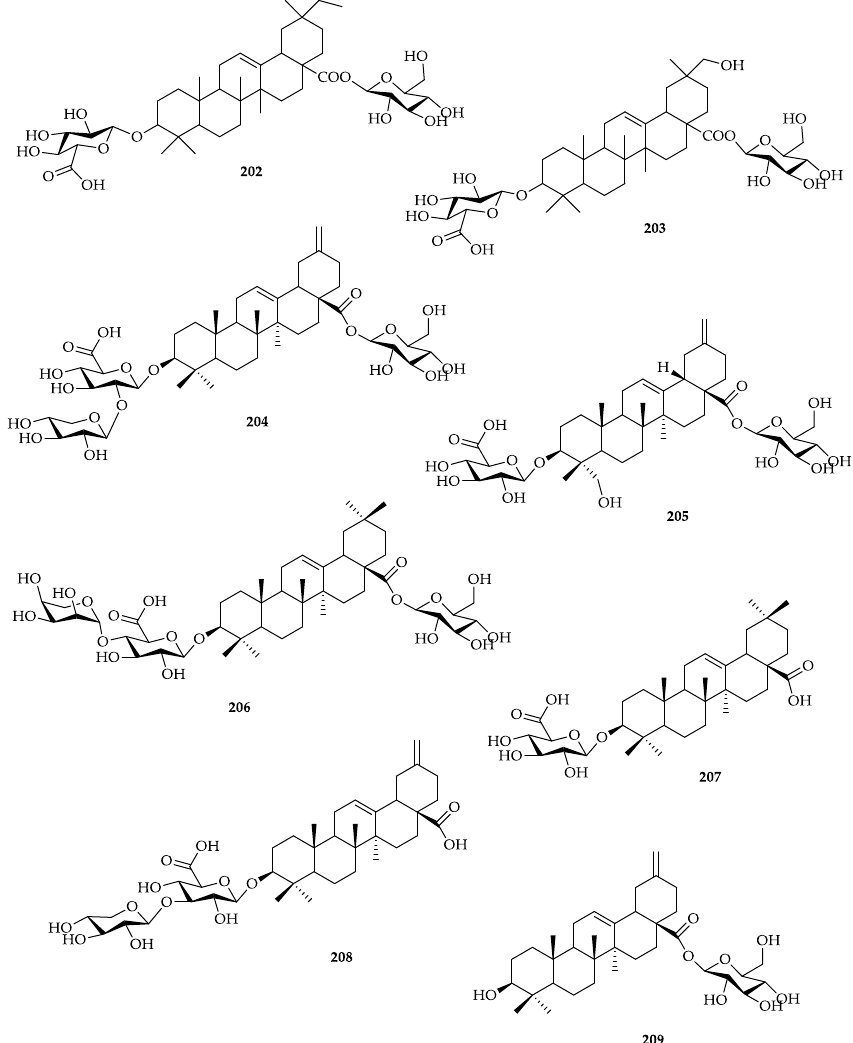
Table 5. Saponins isolated from Eriocaulaceae